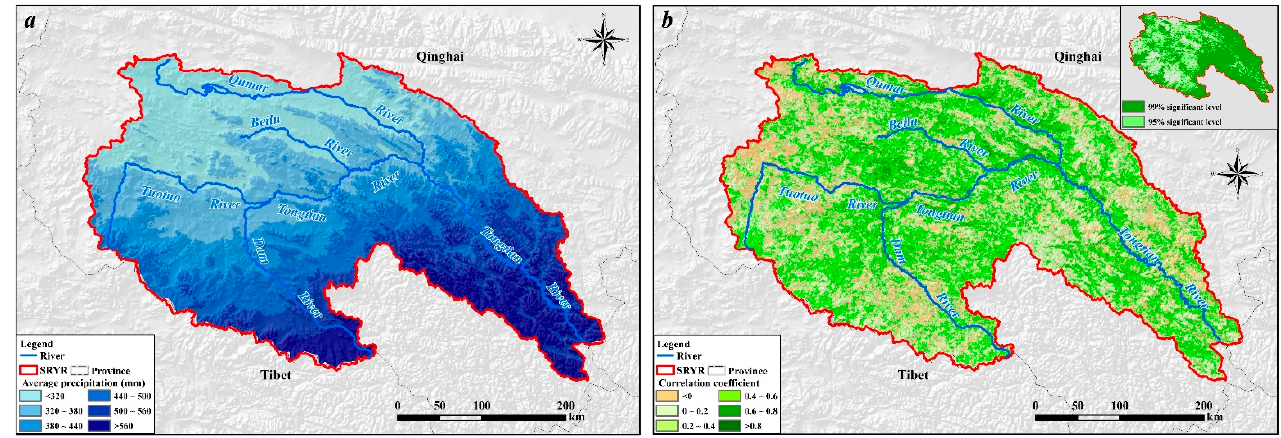
Figure 8. Average precipitation of SRYR ( a ) and correlation coefficient between SCD and precipita- tion ( b ).